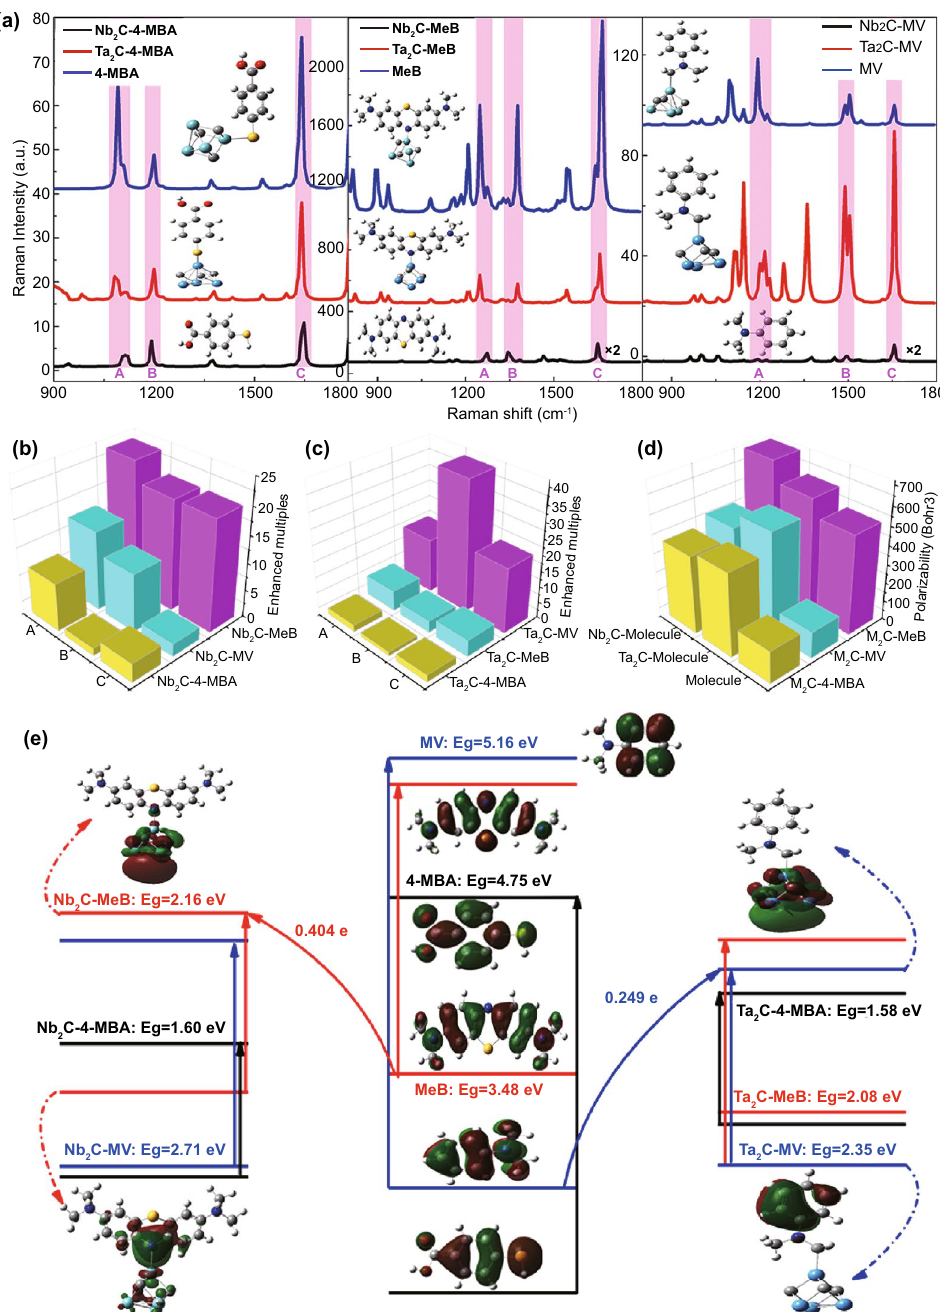
Fig. 1 a Static Raman spectra of isolated molecules 4-MBA, MeB, MV, and complexes Nb 2 C-4-MBA, Ta 2 C-4-MBA, Nb 2 C-MeB, Ta 2 C-MeB, Nb 2 C-MV, Ta 2 C-MV. b , c The comparison of Raman enhanced multiples for Nb 2 C-based complexes ( b ): Nb 2 C-4-MBA, Nb 2 C-MeB, Nb 2 C-MV, and Ta 2 C-based complexes ( c) : Ta 2 C-4-MBA, Ta 2 C-MeB, Ta 2 C-MV for calculated Raman models at A, B, C Raman shifts, respectively. d Calculated polarizabilities of isolated molecules: 4-MBA, MeB, MV, and these molecules adsorbed on Nb 2 C and Ta 2 C clusters, respec- tively. e Energy level distributions and HOMO/LUMO illustrations of 4-MBA, MeB, MV molecules, Nb 2 C-4-MBA, Nb 2 C-MeB, Nb 2 C-MV, Ta 2 C-4-MBA, Ta 2 C-MeB, Ta 2 C-MV